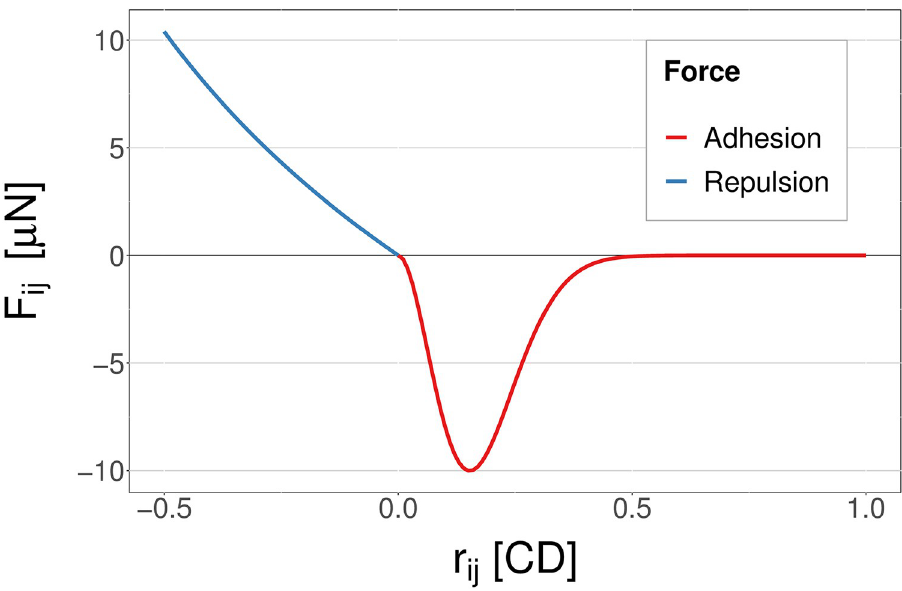
Fig 8. The signed magnitude of the adhesive and repulsive forces ( F ij ) experienced between two cells ( i and j ) as a function of r ij , the distance between the cell boundaries. CD: Cell